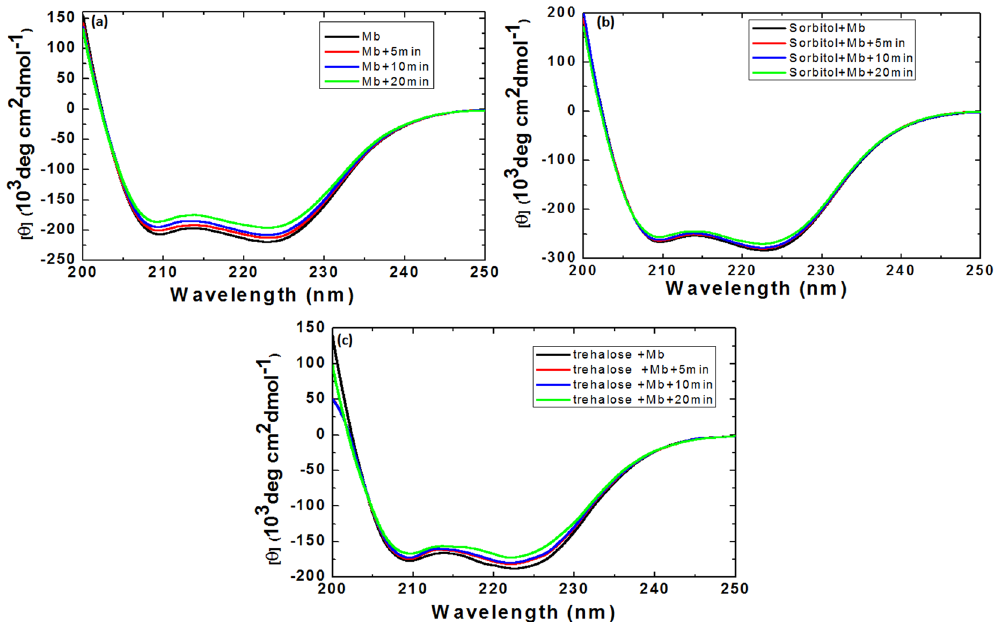
Figure 4. Analysis of Myoglobin secondary structure change using CD spectroscopy after treatment with DBD plasma for different time intervals such as 20, 10 and 5 min ( a ) control Myoglobin, ( b ) Myoglobin + sorbitol and ( c ) +